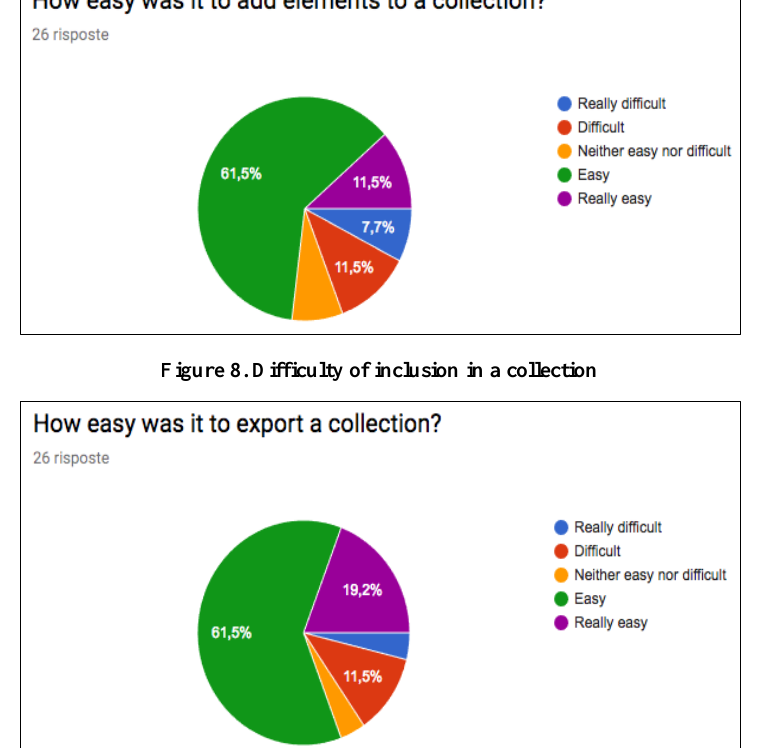
Figure 9. Difficulty of exporting a